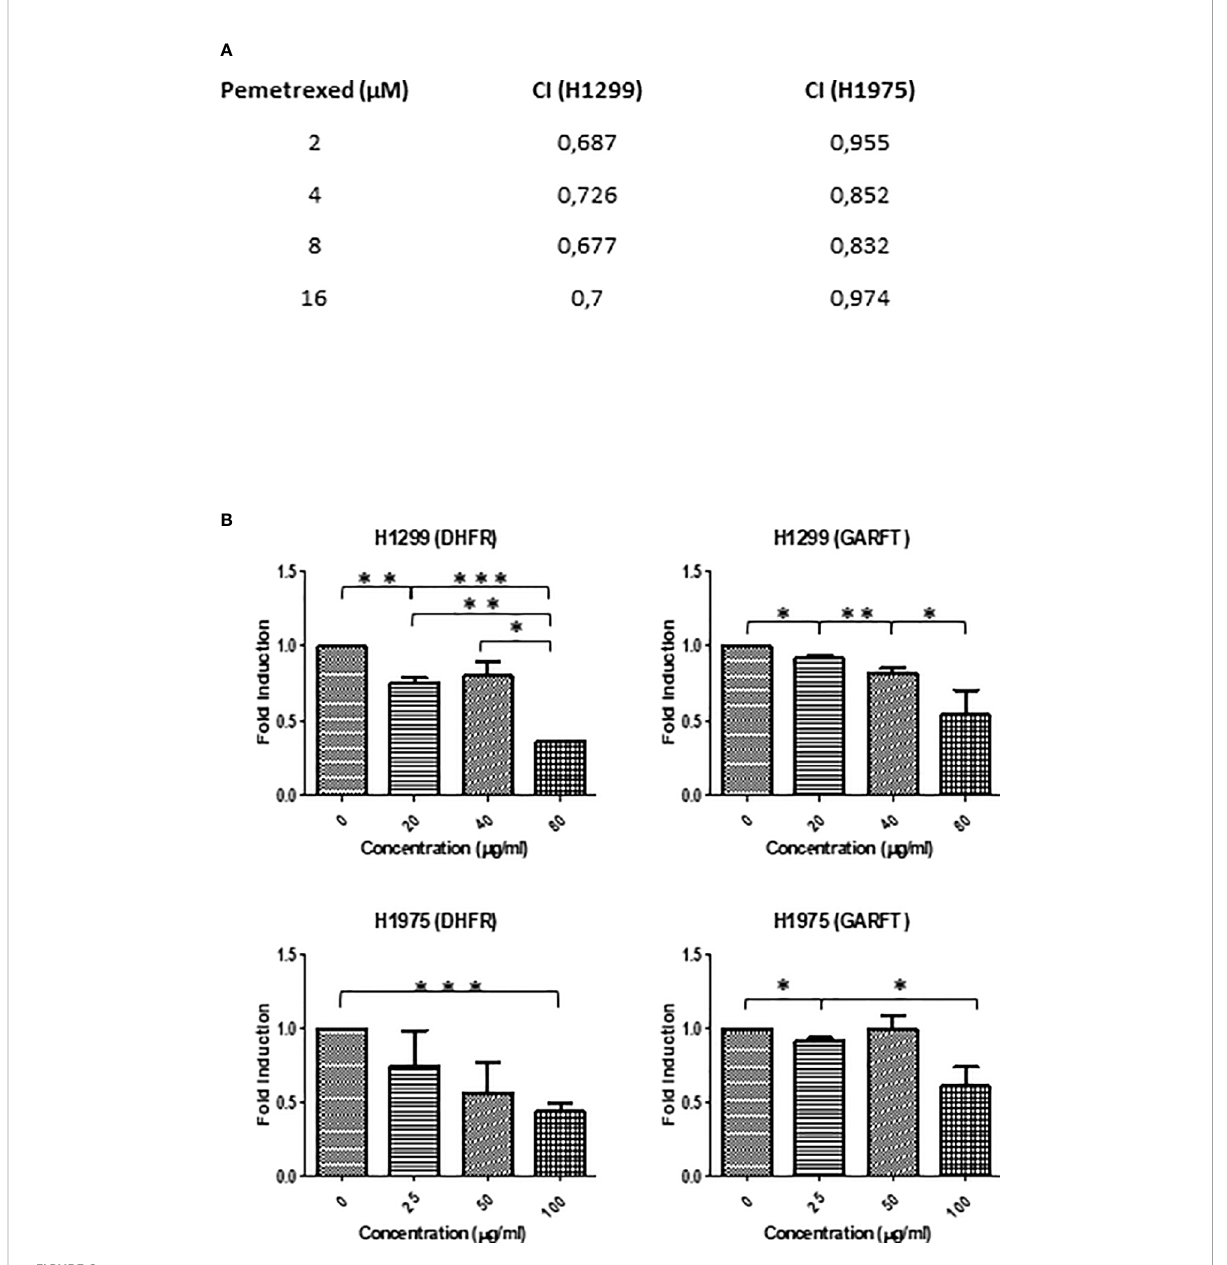
FIGURE 8 (A) SFRE synergised with pemetrexed in the inhibition of NSCLC cell proliferation. NSCLC cells were pre-treated with the extract for 3h at a – Talalay method. (B) SFRE diminished the expression of fi xed dose of 1/2 IC 50 for H1299 and H1975. Combinatory index (CI) according to Chou DHFR and GARFT , in a dose dependent manner. Results are shown in relation to non-treated cells and normalized to the endogenous control B2M . Results are expressed as the mean ± SEM of three independent experiments, each performed in triplicates. Asterisks *, **, *** indicate p- values < 0.05, 0.01 and 0.005,